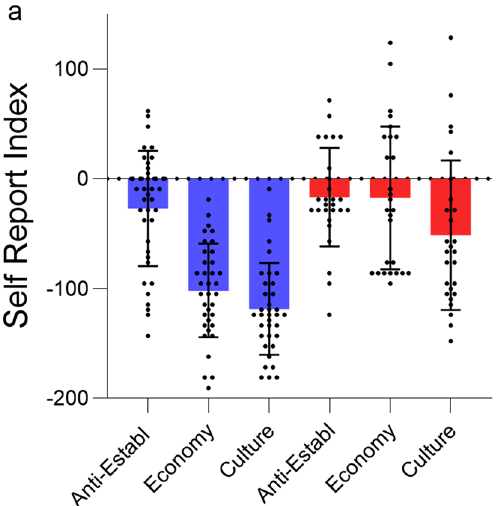
Figure 1. Task performance. SRI for the three issue dimensions in voters of mainstream (blue) and populist (red) parties. More positive values correspond to more populist views. The SRI was polarized for economy and culture issues, but not for anti-establishment